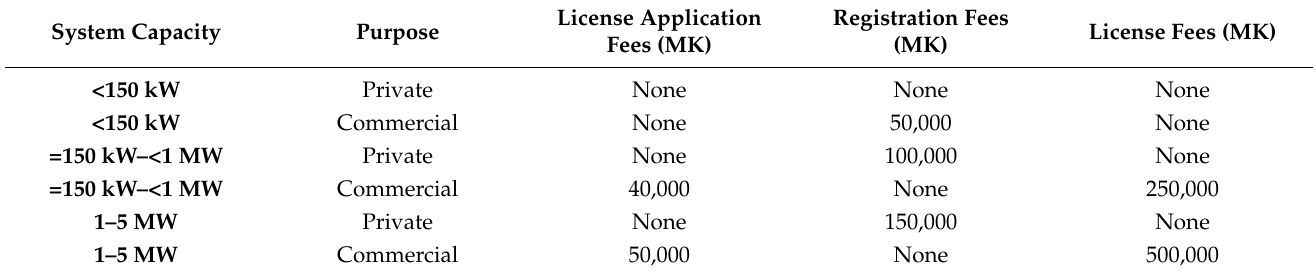
Table 4. Mini-grid license and registration fees in Malawi (adapted from [32]). MK = Malawian